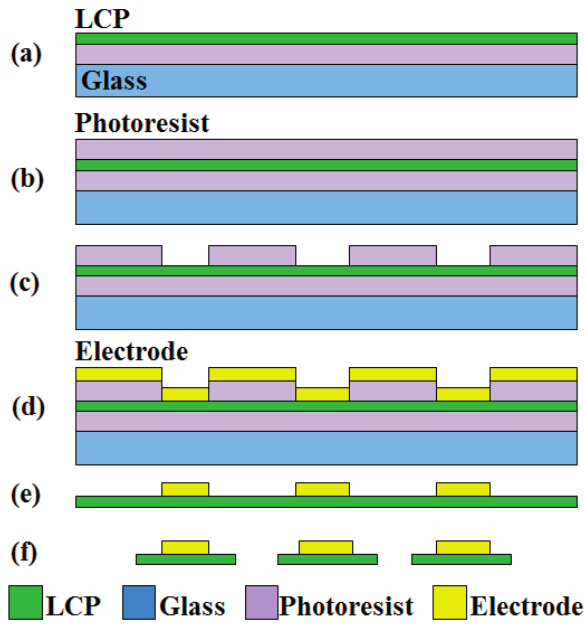
Figure 1. Flow chart depicting the fabrication process of the flexible electrode: ( a ) Liquid crystal polymer (LCP) bonded with glass wafer; ( b ) spin-coating of the photoresist; ( c ) patterning of the photoresist; ( d ) sputtering of the electrode; ( e ) patterning of the electrode, and ( f ) cutting of the electrode into